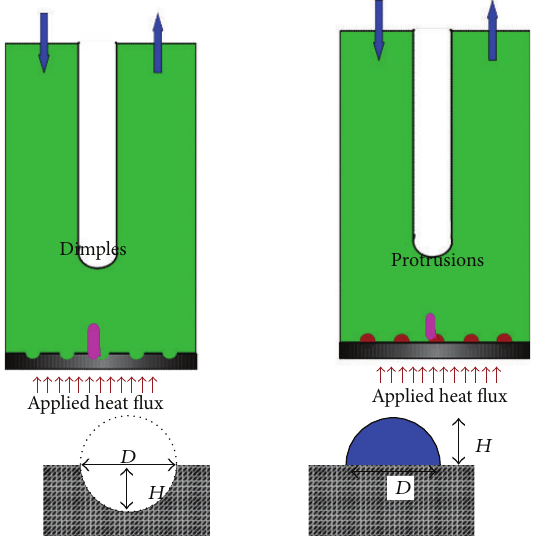
Figure 8: Dimple and protrusion configurations investigated in a two-pass channel for tip-wall cooling by Sund´en et al.